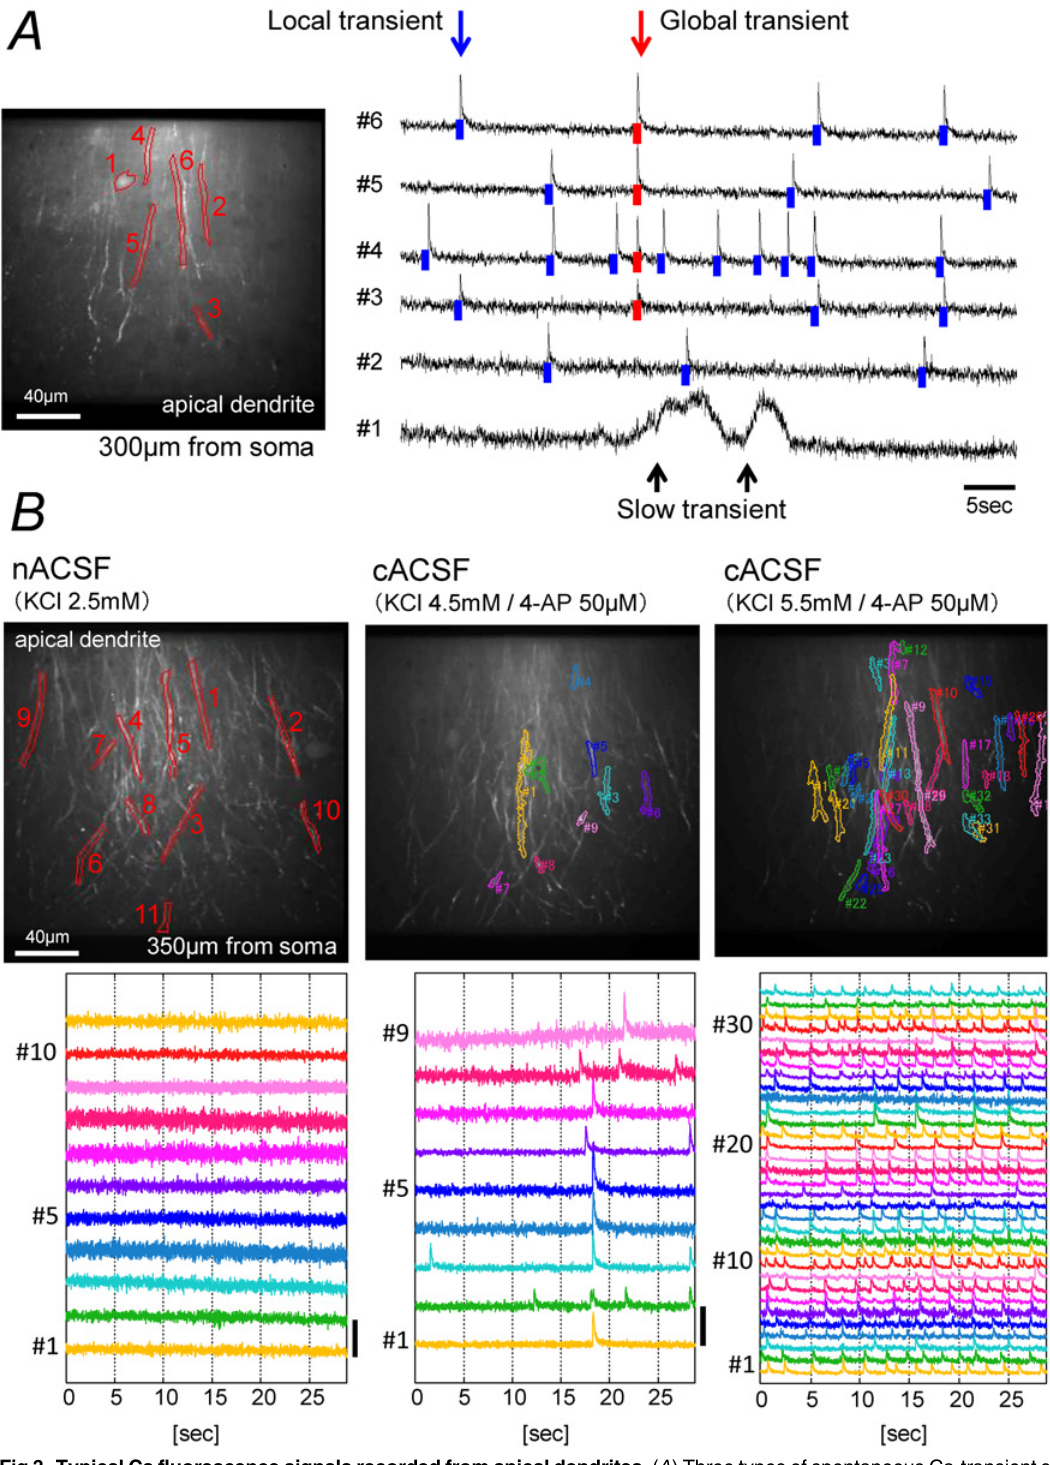
Fig 3. Typical Ca fluorescence signals recorded from apical dendrites. ( A ) Three types of spontaneous Ca-transient seen in ACSF/4-AP containing 3.75 mM K + ion. Left panel: The field of view. The center of the image field was 300 μ m from the border between the cell layer and the str. pyramidale. Six ROIs were selected by drawing lines around brightly stained neurites. Right panel: Time-course of the fluorescence intensity of the ROIs shown in the left panel. A round shaped cell (ROI #1) showed slow-transients, while dendritic branches (ROI #2 – 6) showed fast-transients. The transients marked with blue bars are local-fast-Ca-transients, while those marked with red bars are global-fast-Ca-transients. ( B ) Fast-Ca-transients in ACSF with different composition. The